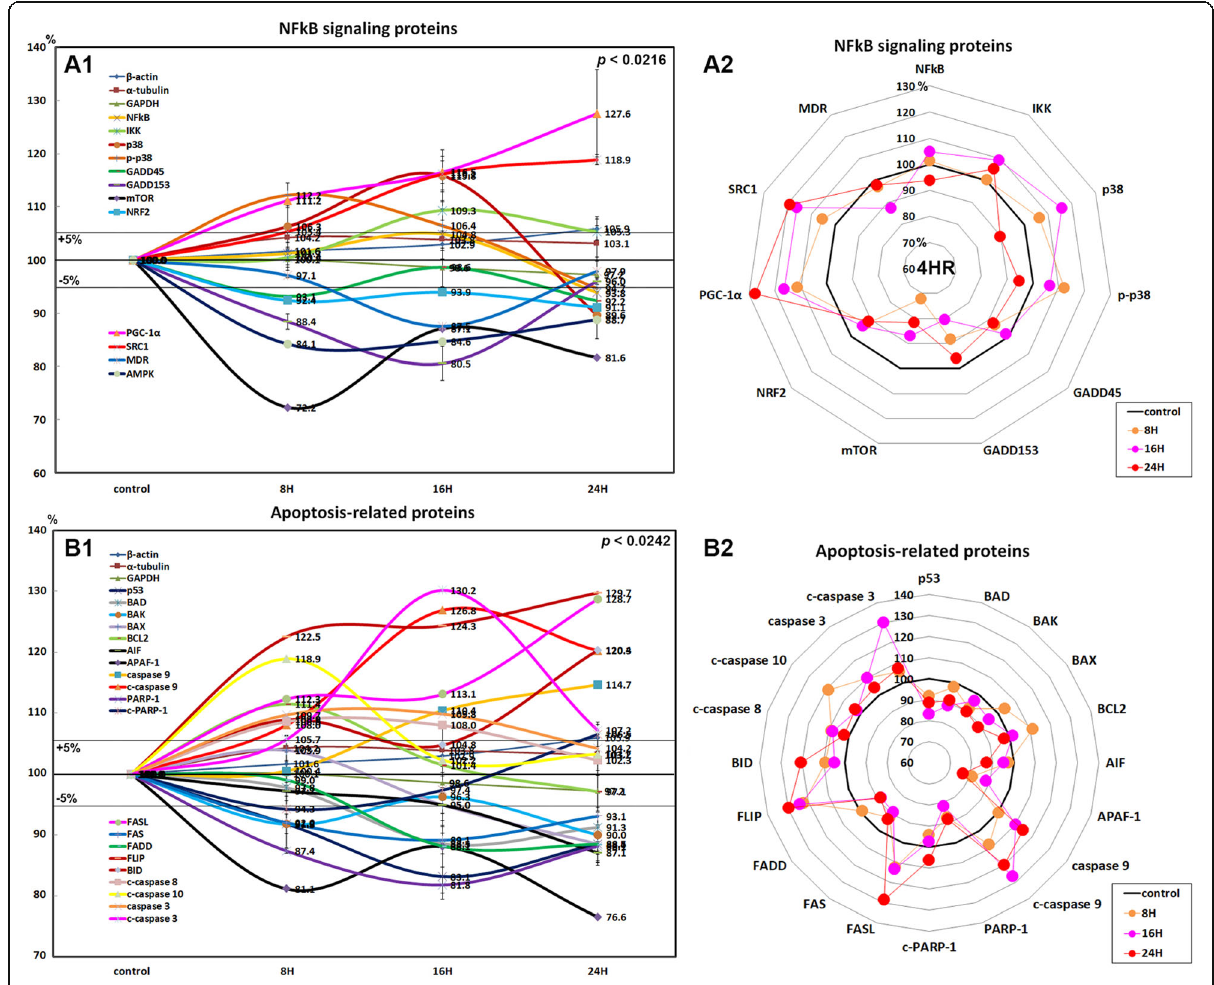
Fig. 2 Expressions of NFkB signaling proteins ( A1 , A2 ) and apoptosis-related proteins ( B1 , B2 ) in 4HR-treated HUVECs as determined by IP-HPLC. The line graphs ( A1 , B1 ) show protein expression patterns on the same scale (%) versus culture time (8, 16, or 24 h), whereas the star plots ( A2 , B2 ) show the differential expression levels of proteins in a circular manner after 8, 16, or 24 h of treatment on appropriate scales